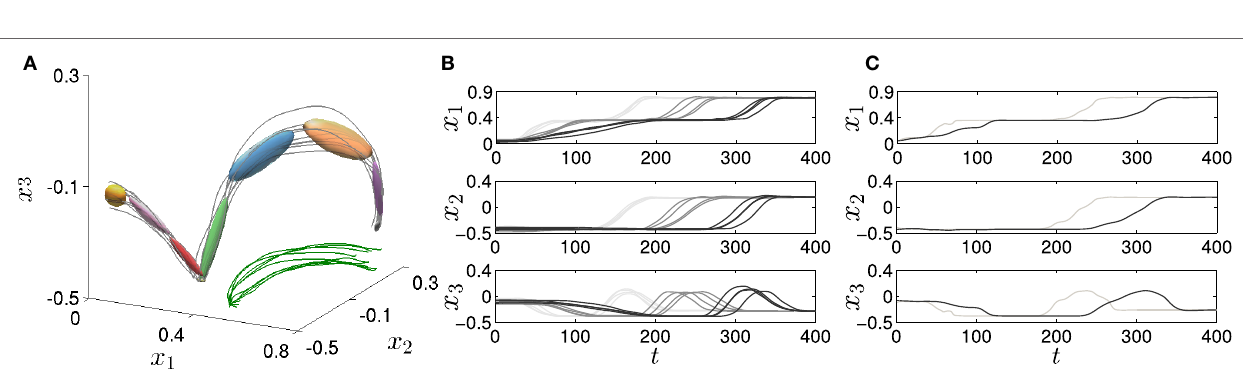
FIGURE 5 | Model, demonstrations, and reproductions of the handover task in the reactive behavior scenario . (A) Task-space view of the model, robot end-effector, and human hand trajectories depicted in gray and green solid lines, respectively. (B) Evolution in time of the demonstrations. (C) Reproductions of the skill. Darker lines display slower human hand